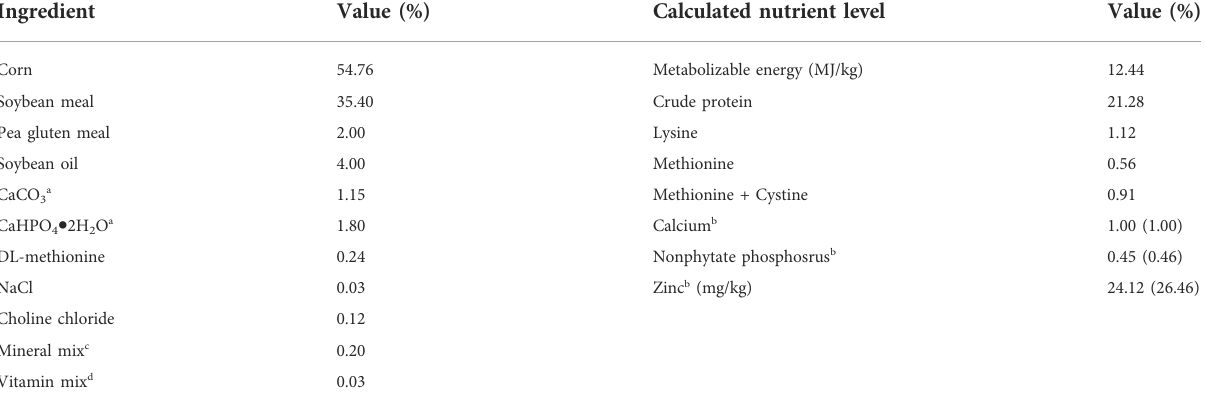
TABLE 1 Ingredient and nutrient composition of the basal diet (as-fed basis).